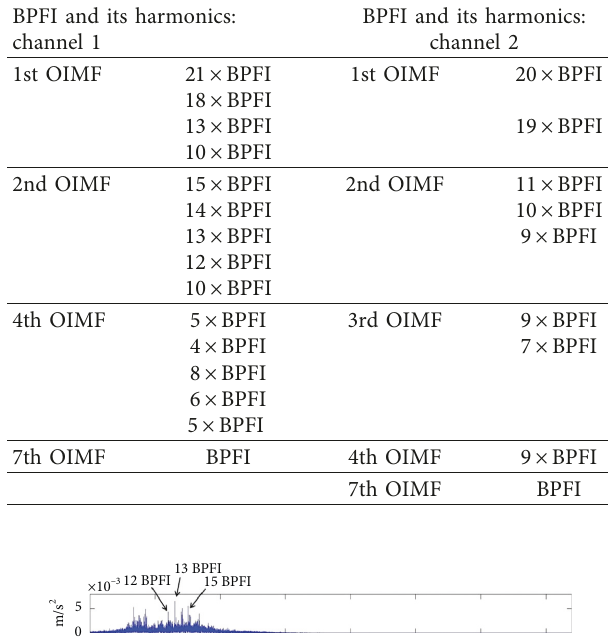
Table 4: Detection of the defect in the inner raceway (BPFI), based on the data processing of channels 1 and 2; list of detected harmonics.